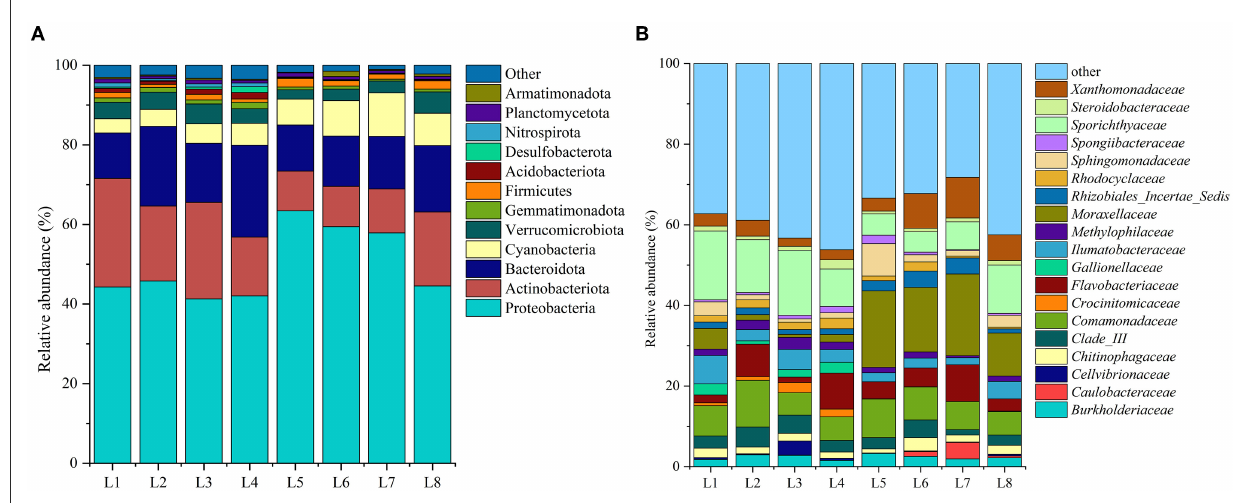
FIGURE3 The microbial community structure, (A) at the phylum level, (B) at the genus level.